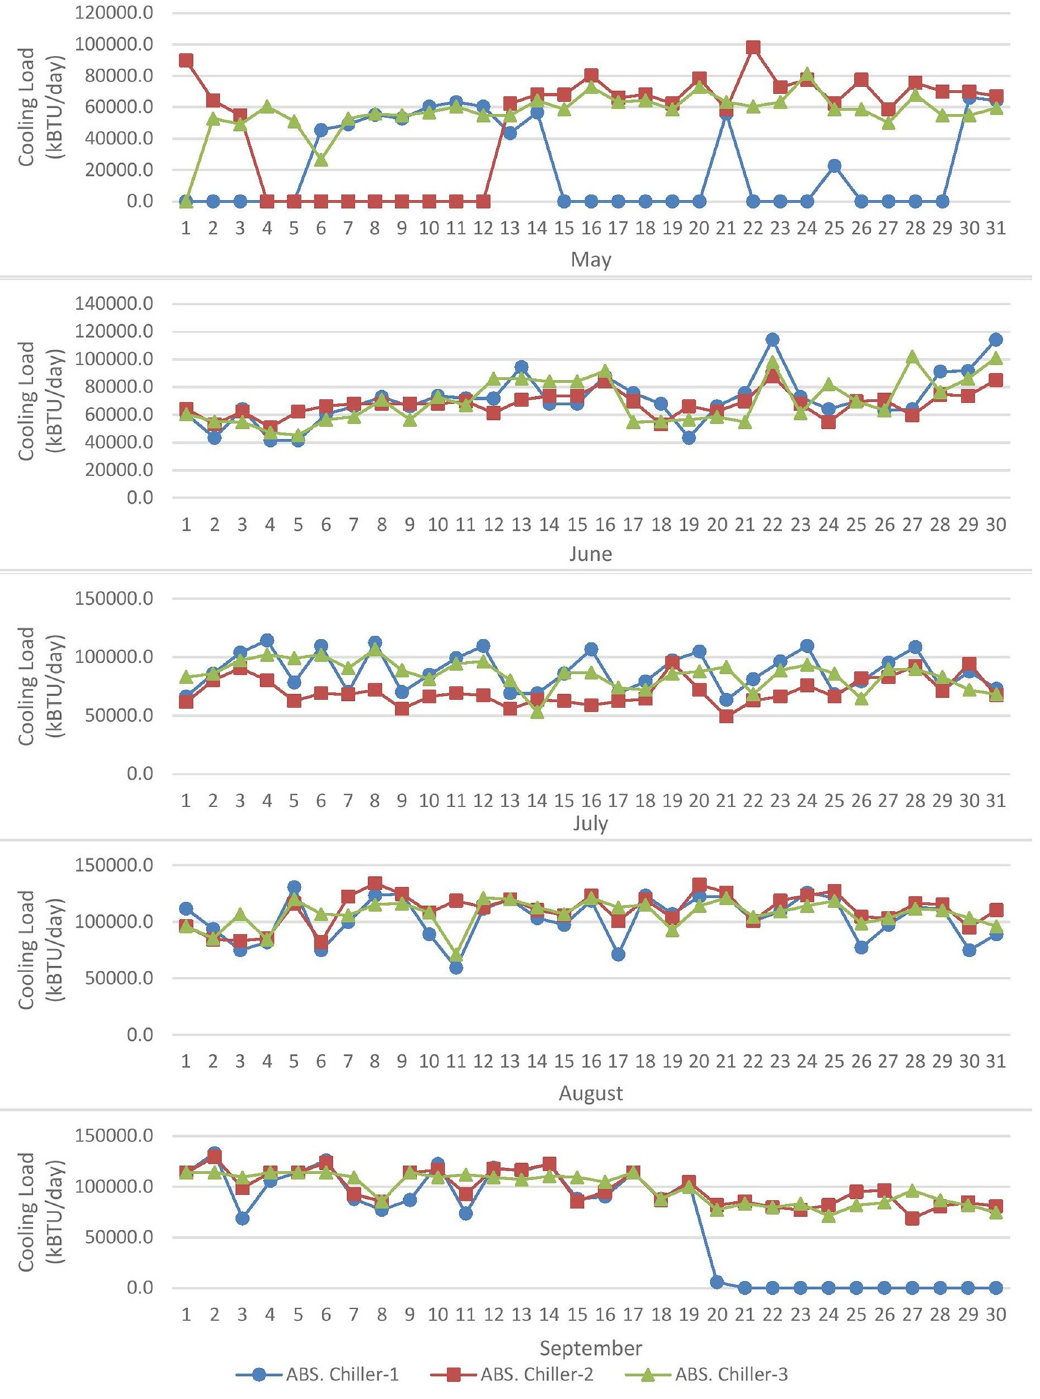
Fig. 4. Absorption chillers cooling load in May –